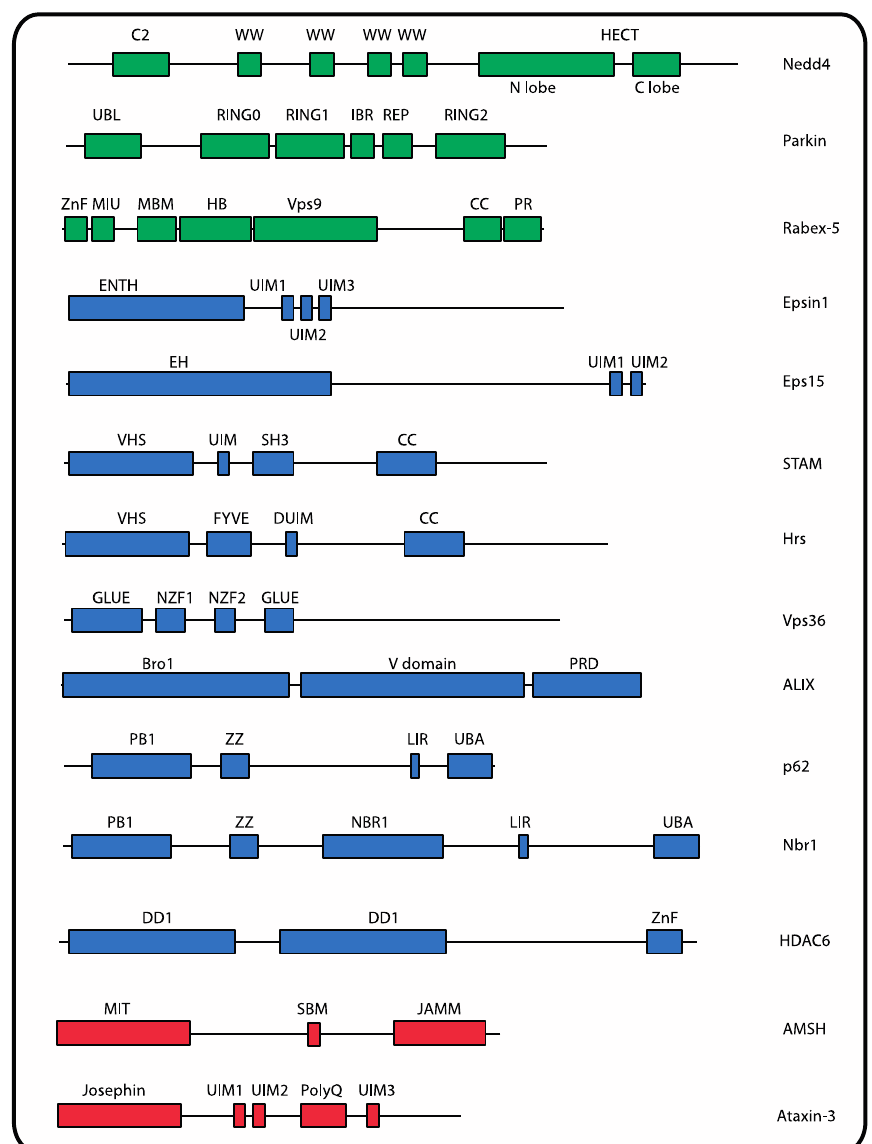
Figure 1. Assembly, disassembly and recognition of UbK63